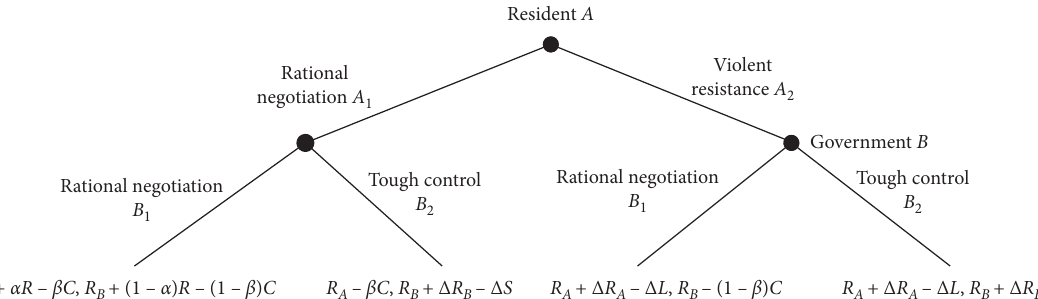
Figure 1: Dynamic flow of evolutional game between the resident and the government in large-scale engineering